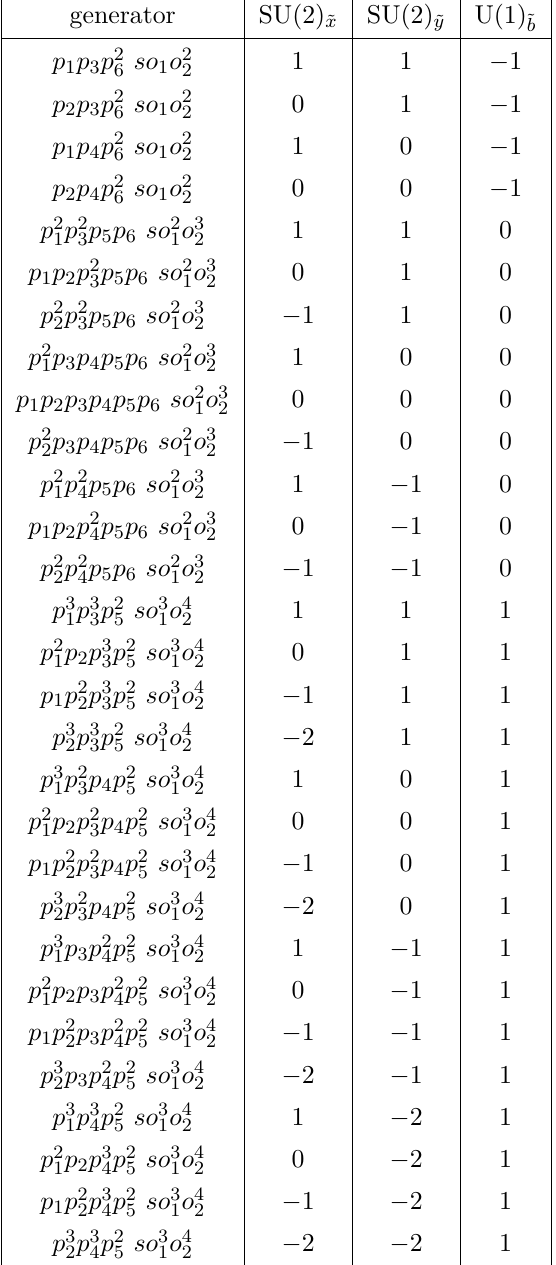
Table 36 . The generators and lattice of generators of the mesonic moduli space of Model 9 in terms of brick matchings with the corresponding flavor